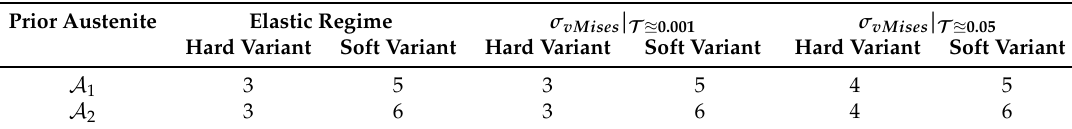
Table 3. Identification of variants with hard response (maximum stress) and soft response (minimum stress) in three different loading regimes; elastic, onset of plasticity and significant plasticity for the loading considered.